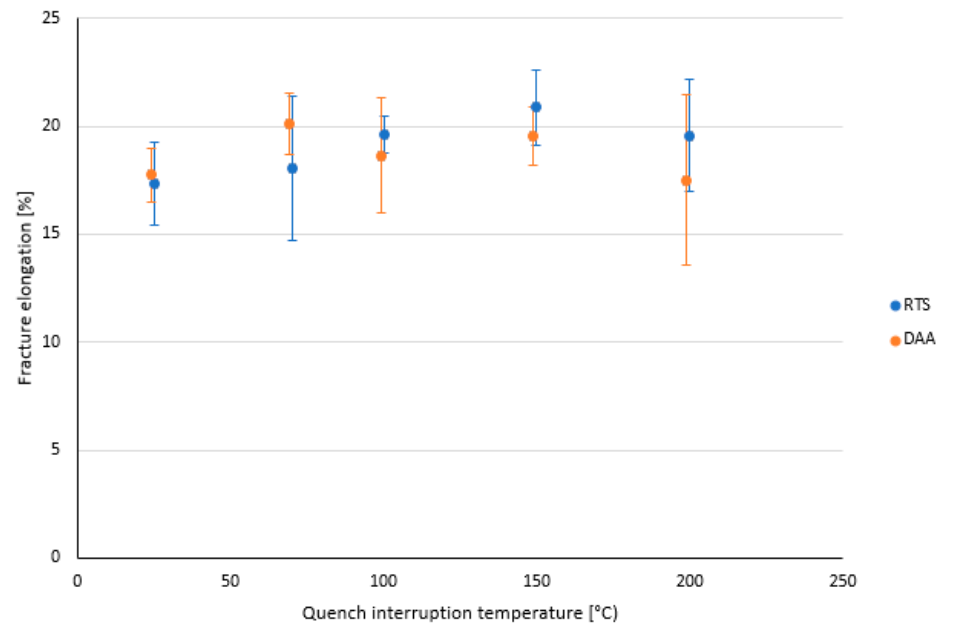
Figure 8. The fracture elongation as a function of quench interruption temperature for samples being stored at room temperature or directly artificially aged. Standard deviations are presented by error bars.